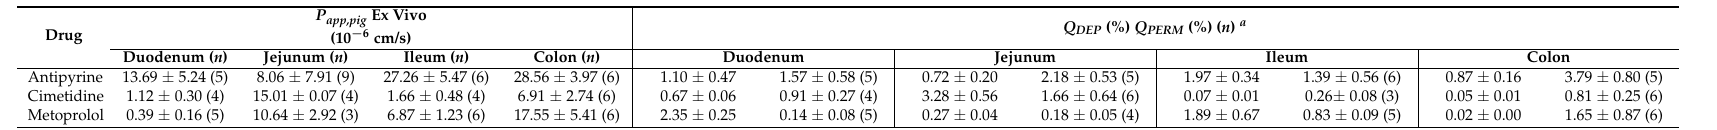
Table 3. The apparent drug permeability coefficients, P app,pig and Q DEP and Q PERM , for drugs in different segments of the small intestine (duodenum, jejunum and ileum) and the